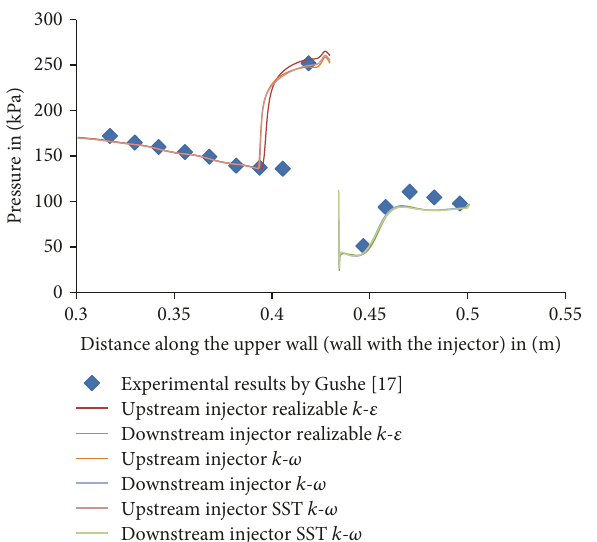
Figure 5: Comparison between numerical results and experimental data for static pressure distribution upstream and downstream the injector along the upper wall using di ff erent turbulence